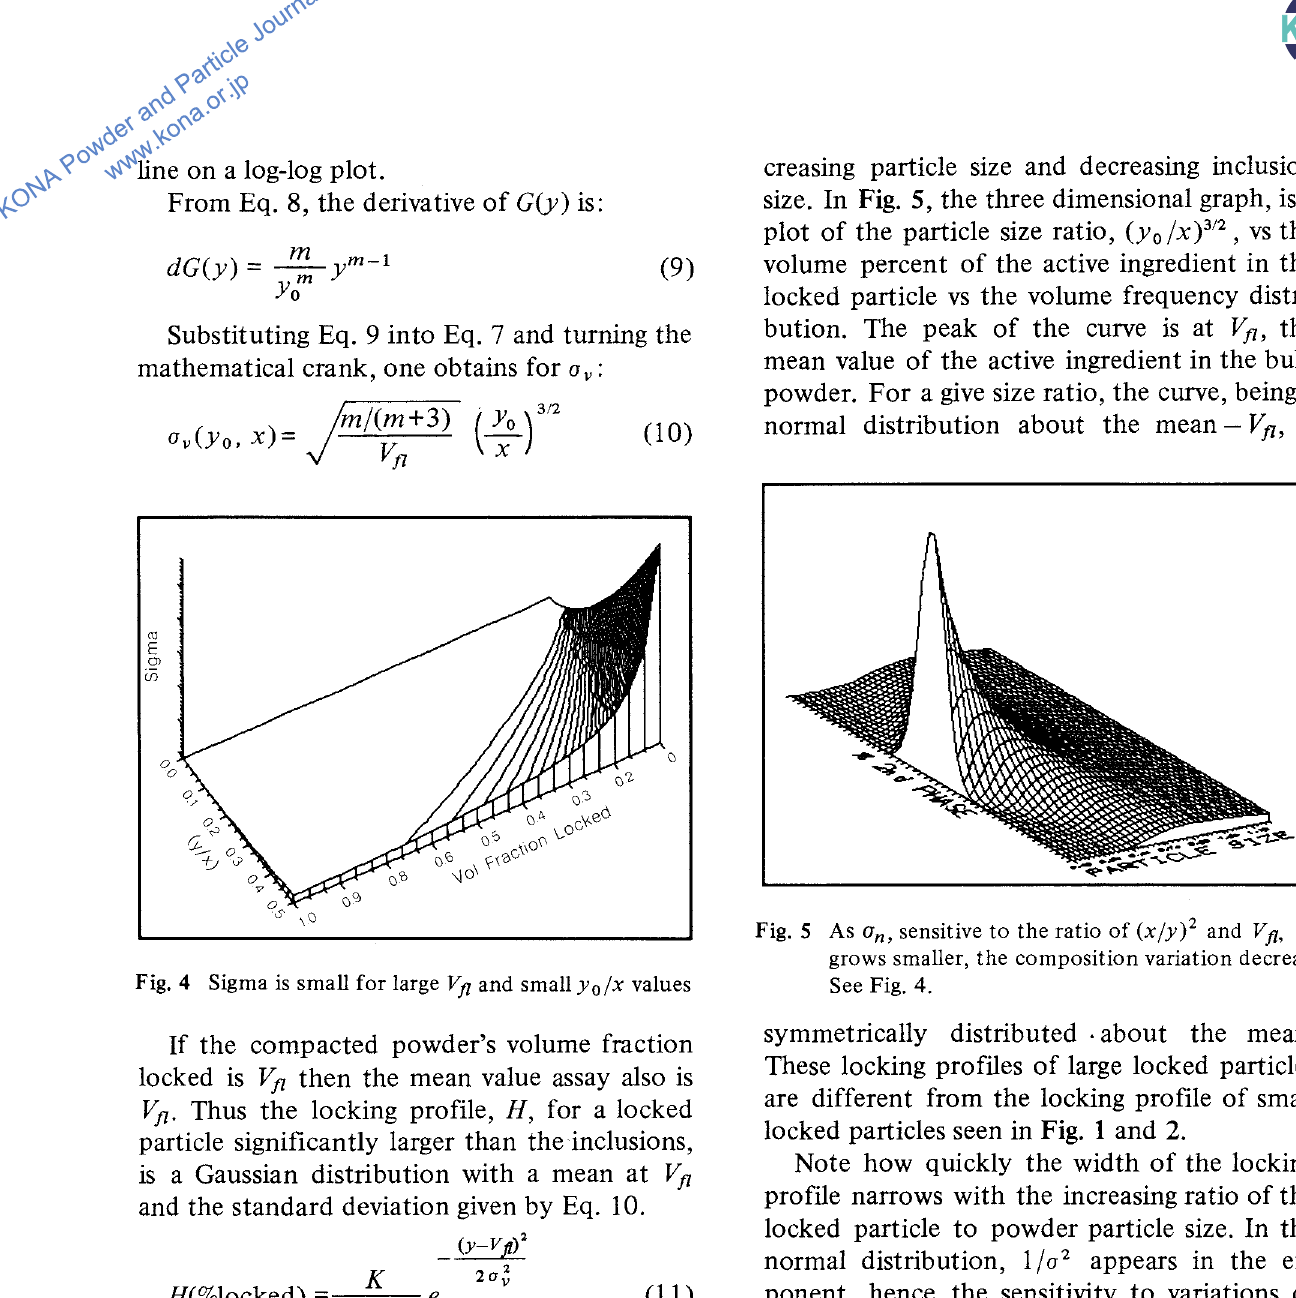
Fig. 5 As On, sensitive to the ratio of (x /Y ) 2 and V fi, grows smaller, the composition variation decreases values See Fig. 0 jx